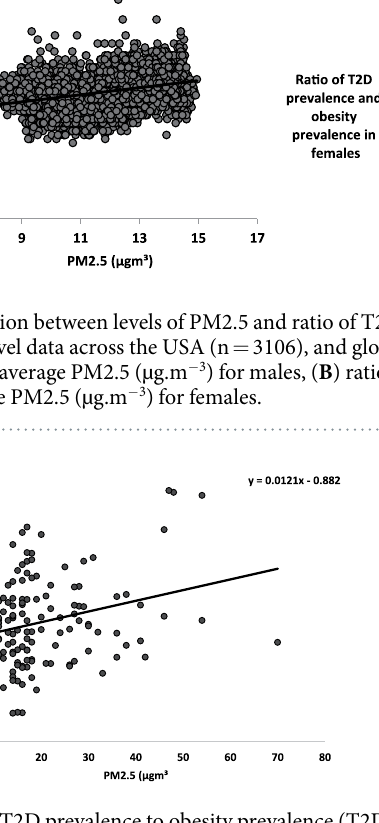
Figure 6. Ratio of T2D prevalence to obesity prevalence (T2D/Ob) against average PM2.5 ( µ g.m − 3 ) across 146